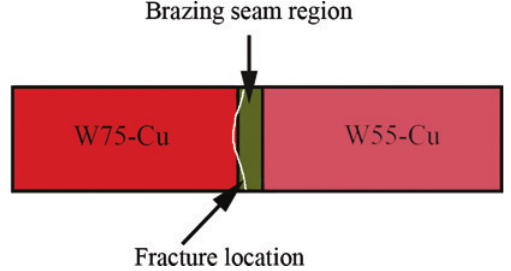
Figure 8: Sketch of the fracture location of the brazed joint.